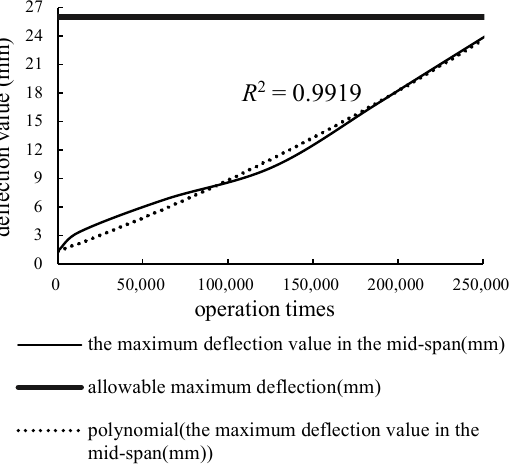
Figure 7. The relationship between taxiway bridge deflection and aircraft operation times. According to various calculations, the correlation coefficient R 2 = 0.9919, indicating that the correlation degree of this curve to the data is as high as 99.19%, is very much in line with the prediction requirements